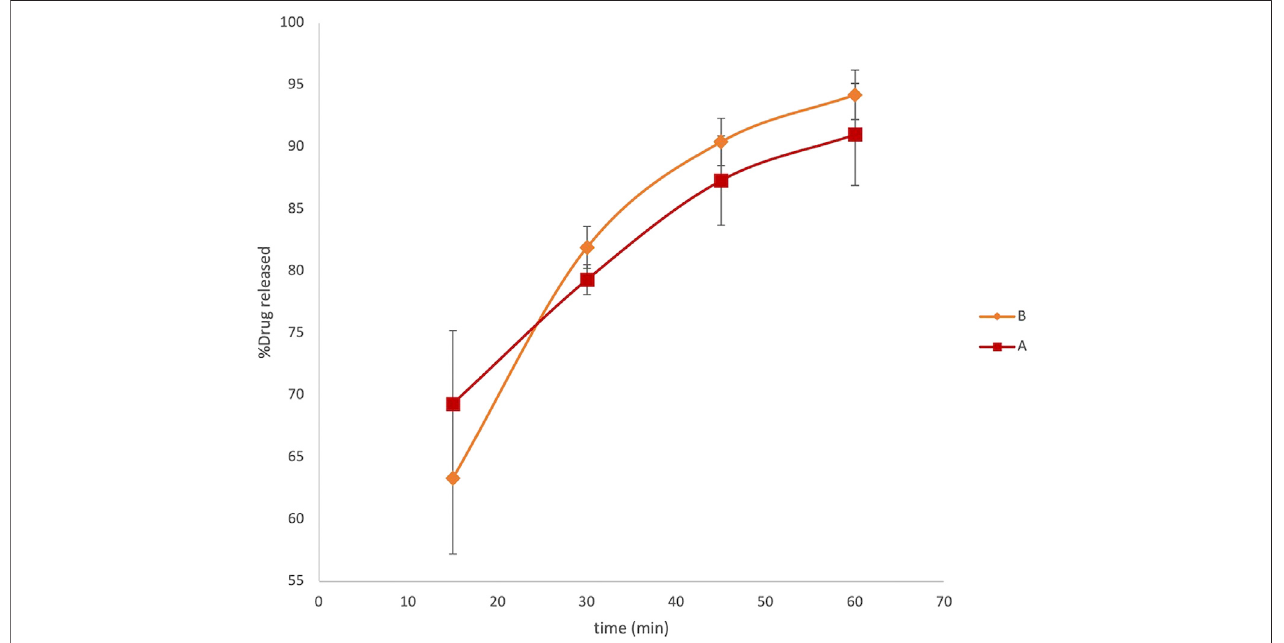
FIGURE 2 | LVN delivery pro fi les obtained by HPLC analysis. The graph shows the percentage of drug released vs time in minutes. Data are the mean of six replicates. RSD% ranged from 1.2 to 6.1%.